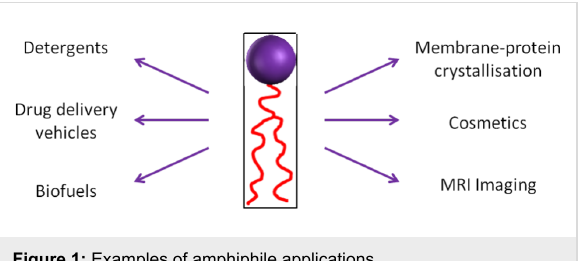
Figure 1: Examples of amphiphile applications.